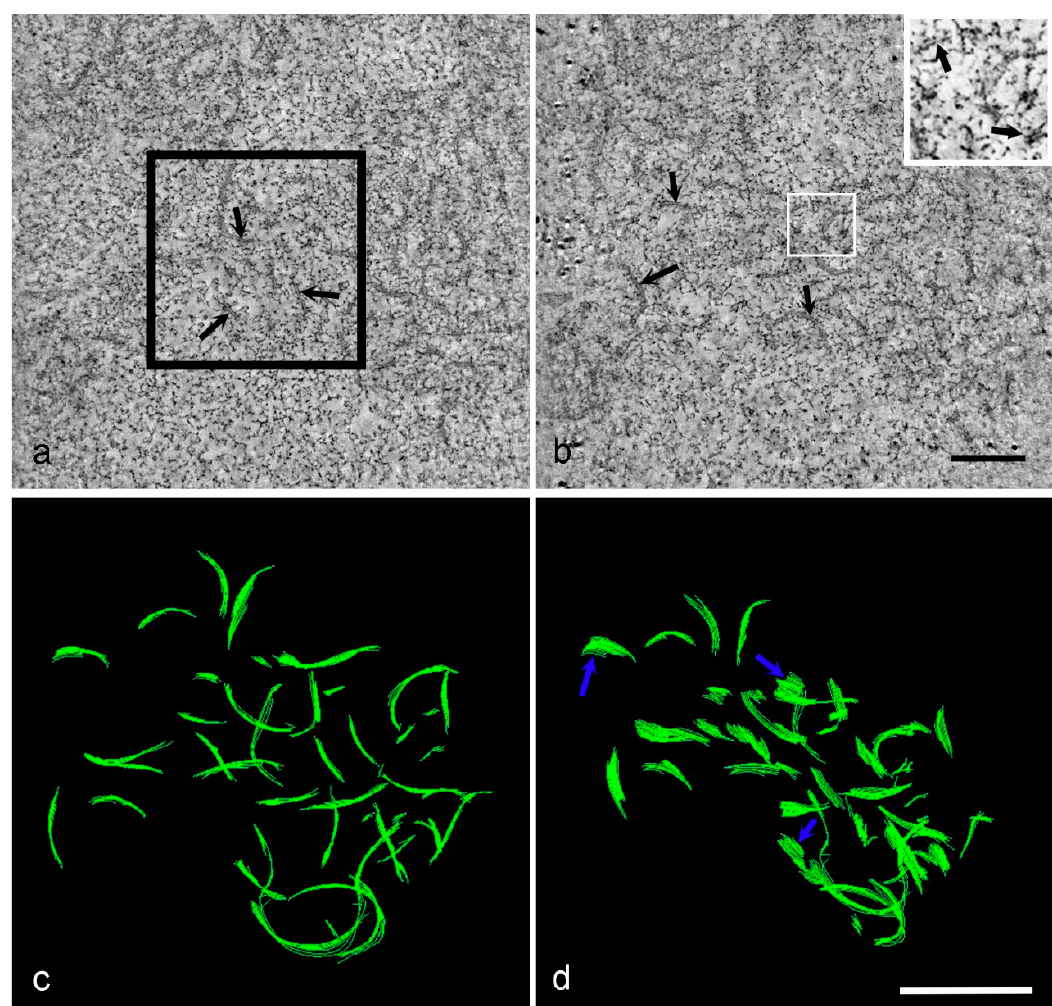
Figure 7. III. Tomographic reconstruction of HPF Vero cells at 18 hpi. Even though this infected cell was from the same sample as those in Figures 5 and 6, it is clearly from a less mature factory. ( a , b ) Two slices from the tomogram in supplemental data (Video S3). ( c , d ) The area in the black box in ( a ) was modeled and views from two angles are shown. Only early forms of the membrane assembly intermediates are visible in this factory, an enlarged image of the area in the white box in ( b ) shows the membranes more clearly after the brightness and contrast were adjusted. Membrane fragments ( a , b , black arrows) and slightly larger curved membranes ( d , blue arrows) appear to be in close association but un-linked. Intermediates with capsid and core protein deposits, immature and mature virions are not present in this region. Scale bars: b, d = 200 nm.